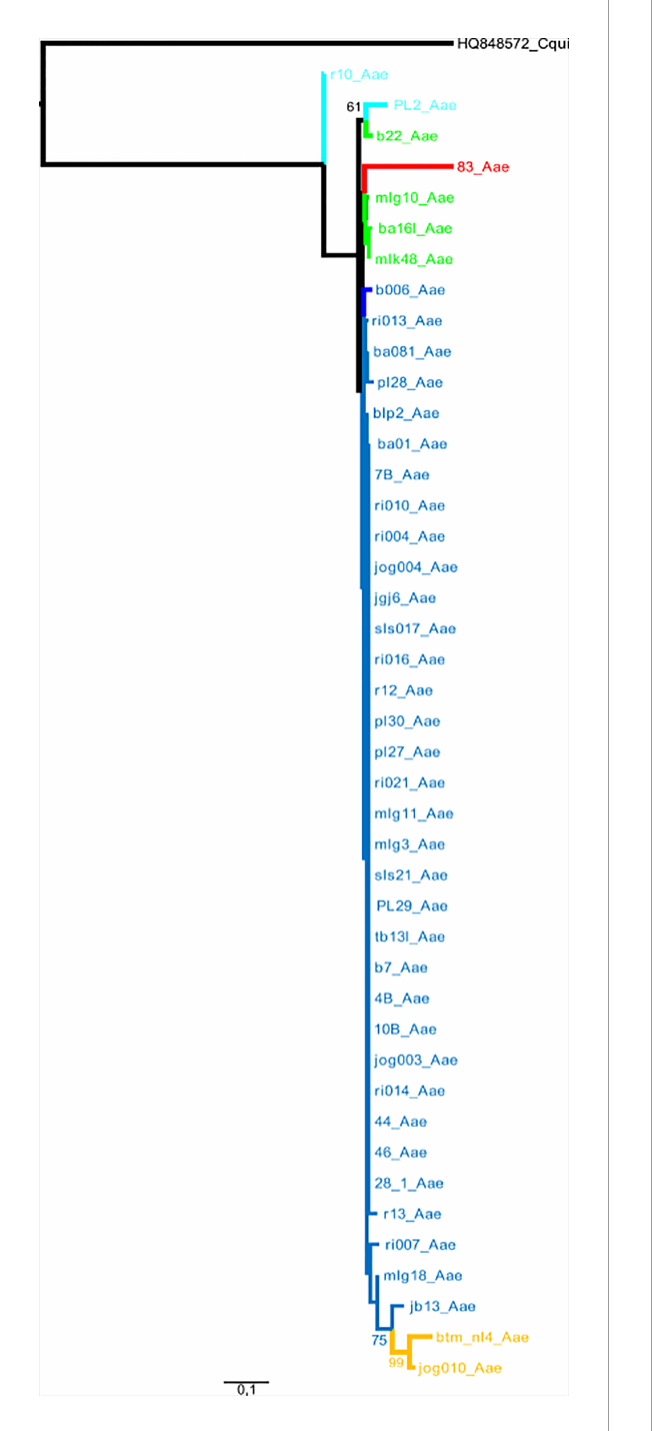
FIGURE 5 | Phylogeny of the Aedes aegypti ITS2 sequences. The phylogenetic tree was built using maximum-likelihood (ML) with the general time reversible model with gama distributed with four discrete categories (GTR + I + G). The clade support was assessed via 500 bootstrap replicates. The tree was rooted using the Culex quinquefasciatus ITS2 sequence (HQ848572) as outgroup. The color code used is that of the ITS2 subclusters given in Supplementary Table 1 .